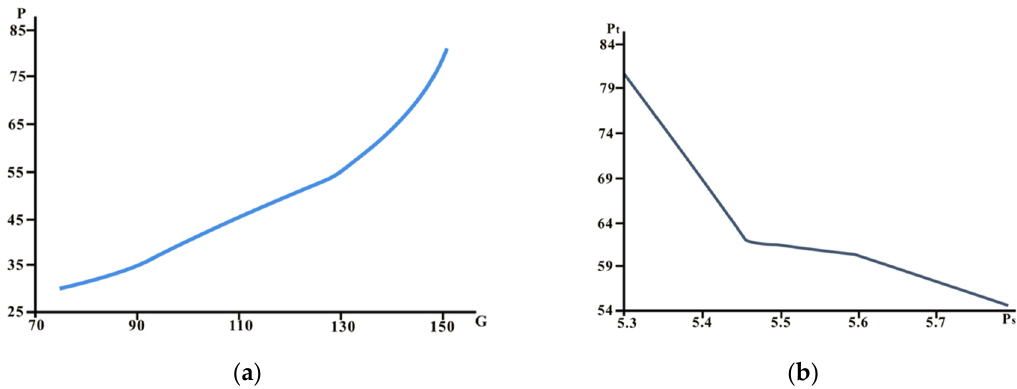
Figure 8. Passport characteristics of the existing VOS ( a ) and experimental dependence of the pressure of the top of the K-1 on the pressure of the steam to the ejectors ( b ).